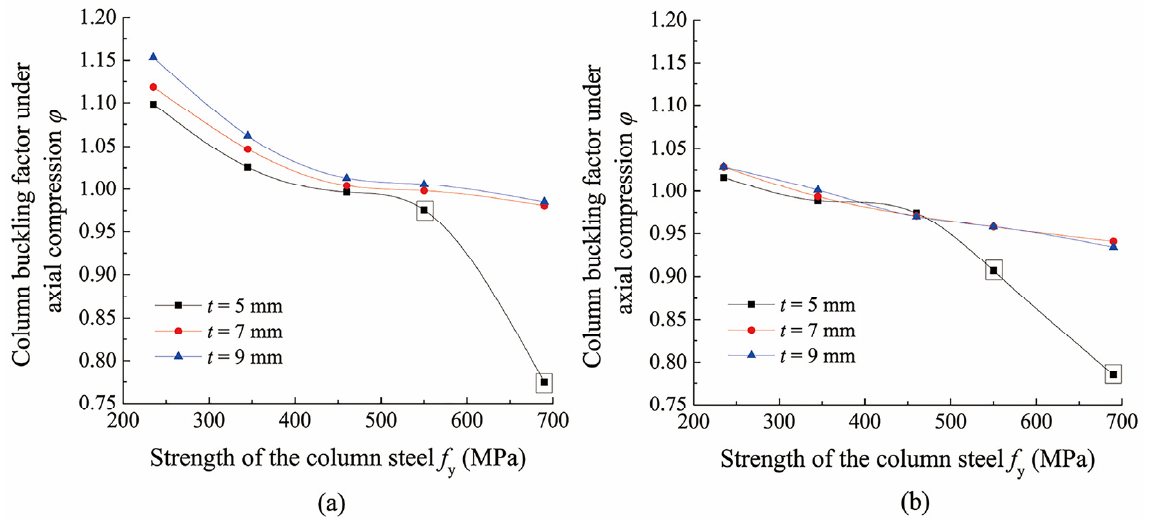
Figure 13. Relationship between column buckling factor and yield strength of column steel for varying wallboard thickness: ( a ) Model M2- t and ( b ) Model M6- t .